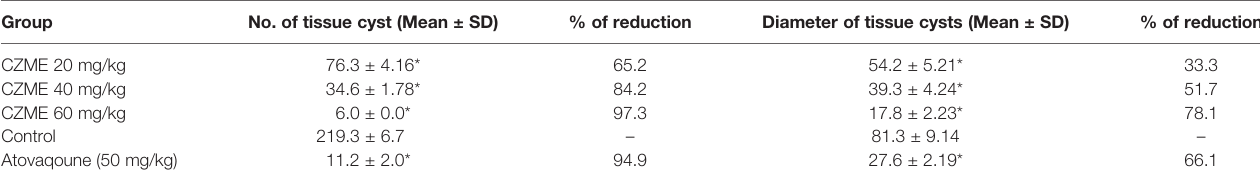
TABLE 3 | The mean number and the mean diameter of the brain tissue cysts followed by pre-treatment of infected mice with C. zeylanicum methanolic extract (CZME) for two weeks.